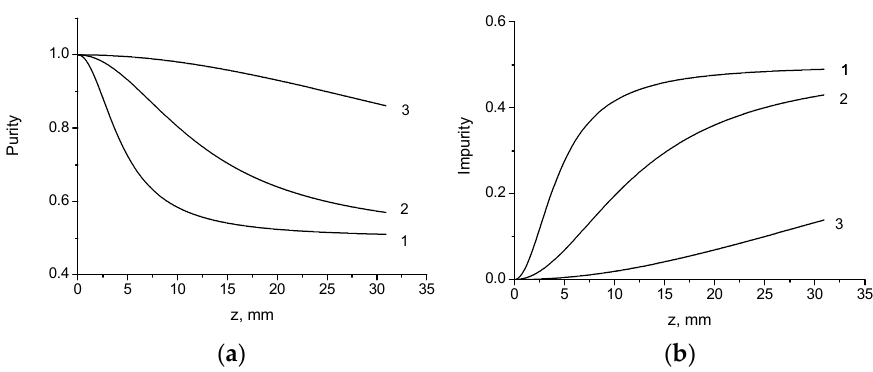
Figure 1. The purity ( a ) and impurity ( b ) as function of distance. 1 − a 0 = 30 µ m; 2 − a 0 = 50 µ m; 3 − a 0 = 100 µ m. λ = 0.63 µ m.